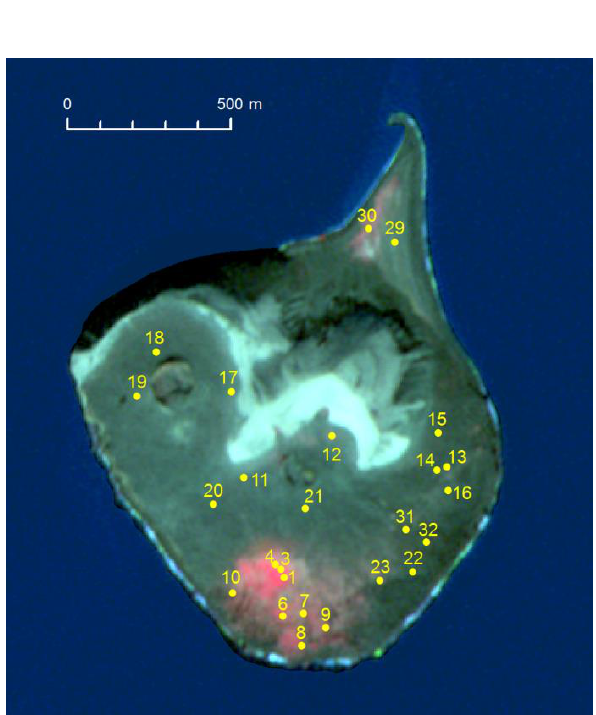
Figure 2. Location of permanent plots on Surtsey, infrared Rapid Eye image from 28 August 2012. Note dense vegetation of gull colony (13ha) on the southern lava and shore community (1ha) on the northern spit. Plots 1, 3, 4, 6–10 and 23 are within the gull